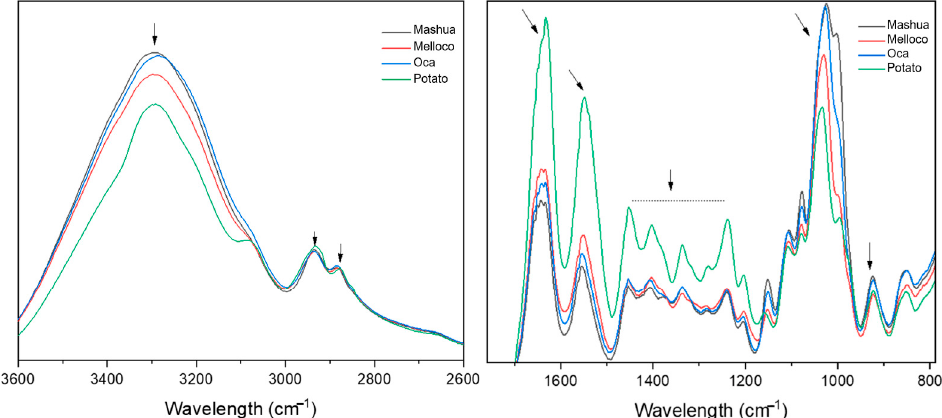
Figure 3. Fourier transform infrared absorption spectra measured on the films formulated with starch from the Andean tubers studied. Arrows highlight representative